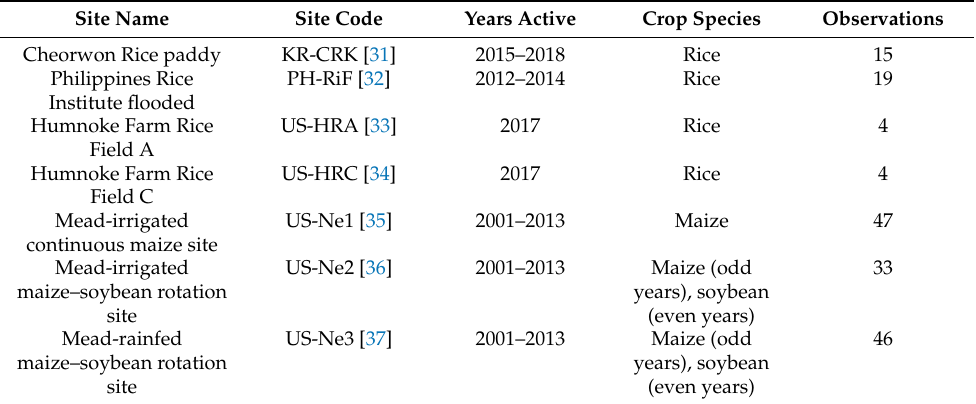
Table 1. Flux tower sites used to derive GPP in situ and LUE in situ